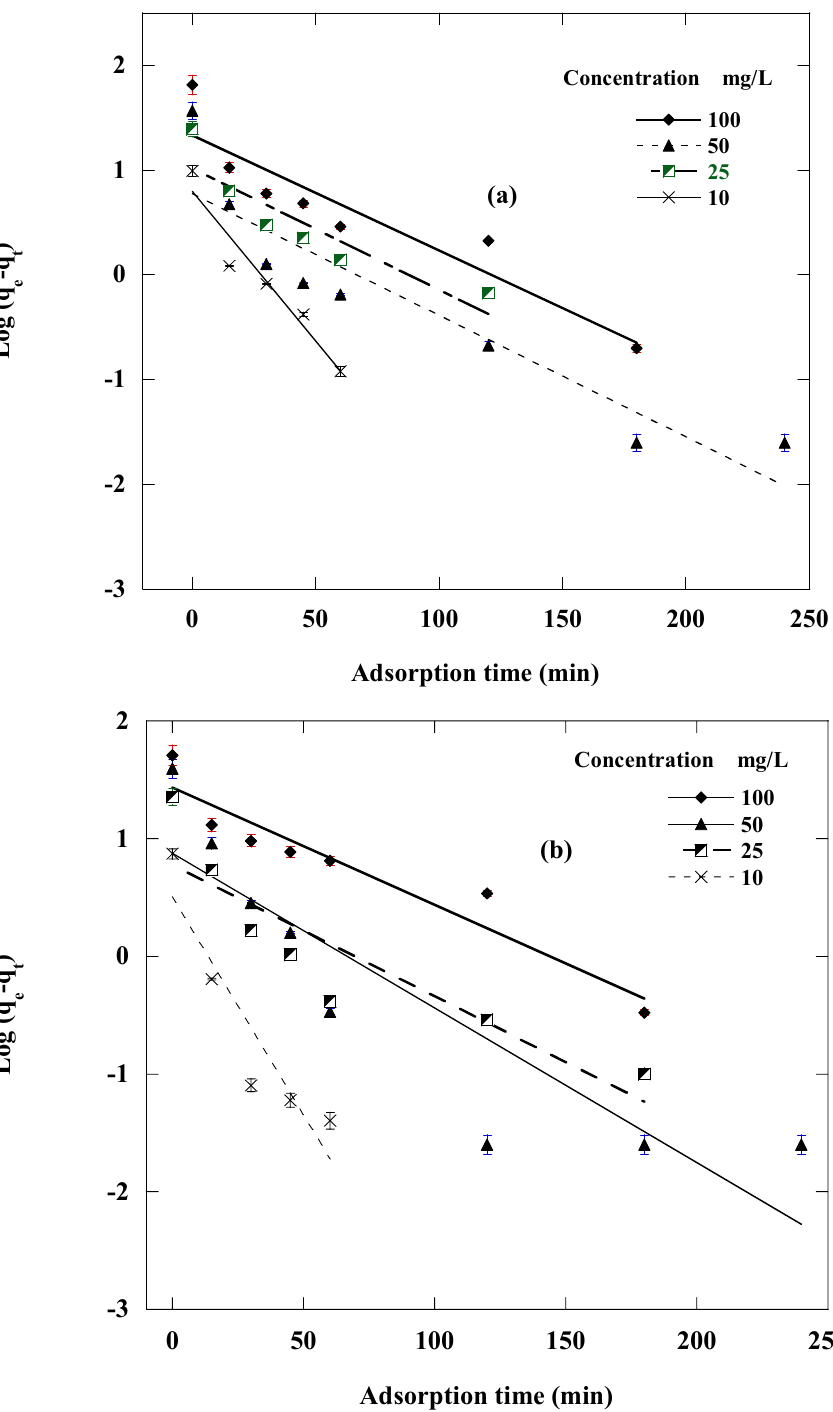
Figure 10. Pseudo-first-order sorption kinetics of Disperse red 60 dye at 20 °C and pH 6 by 50 mg of: ( a ) CF, ( b